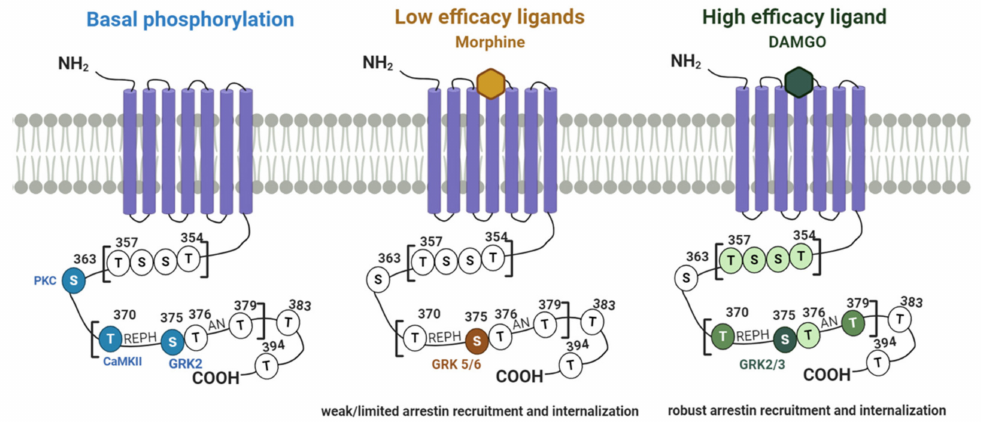
Figure 1. The MOR phosphorylation barcode. MOR residues and kinases involved in constitutive phosphorylation (basal) or upon low and high e ffi cacy agonist-induced phosphorylation (e.g., morphine and